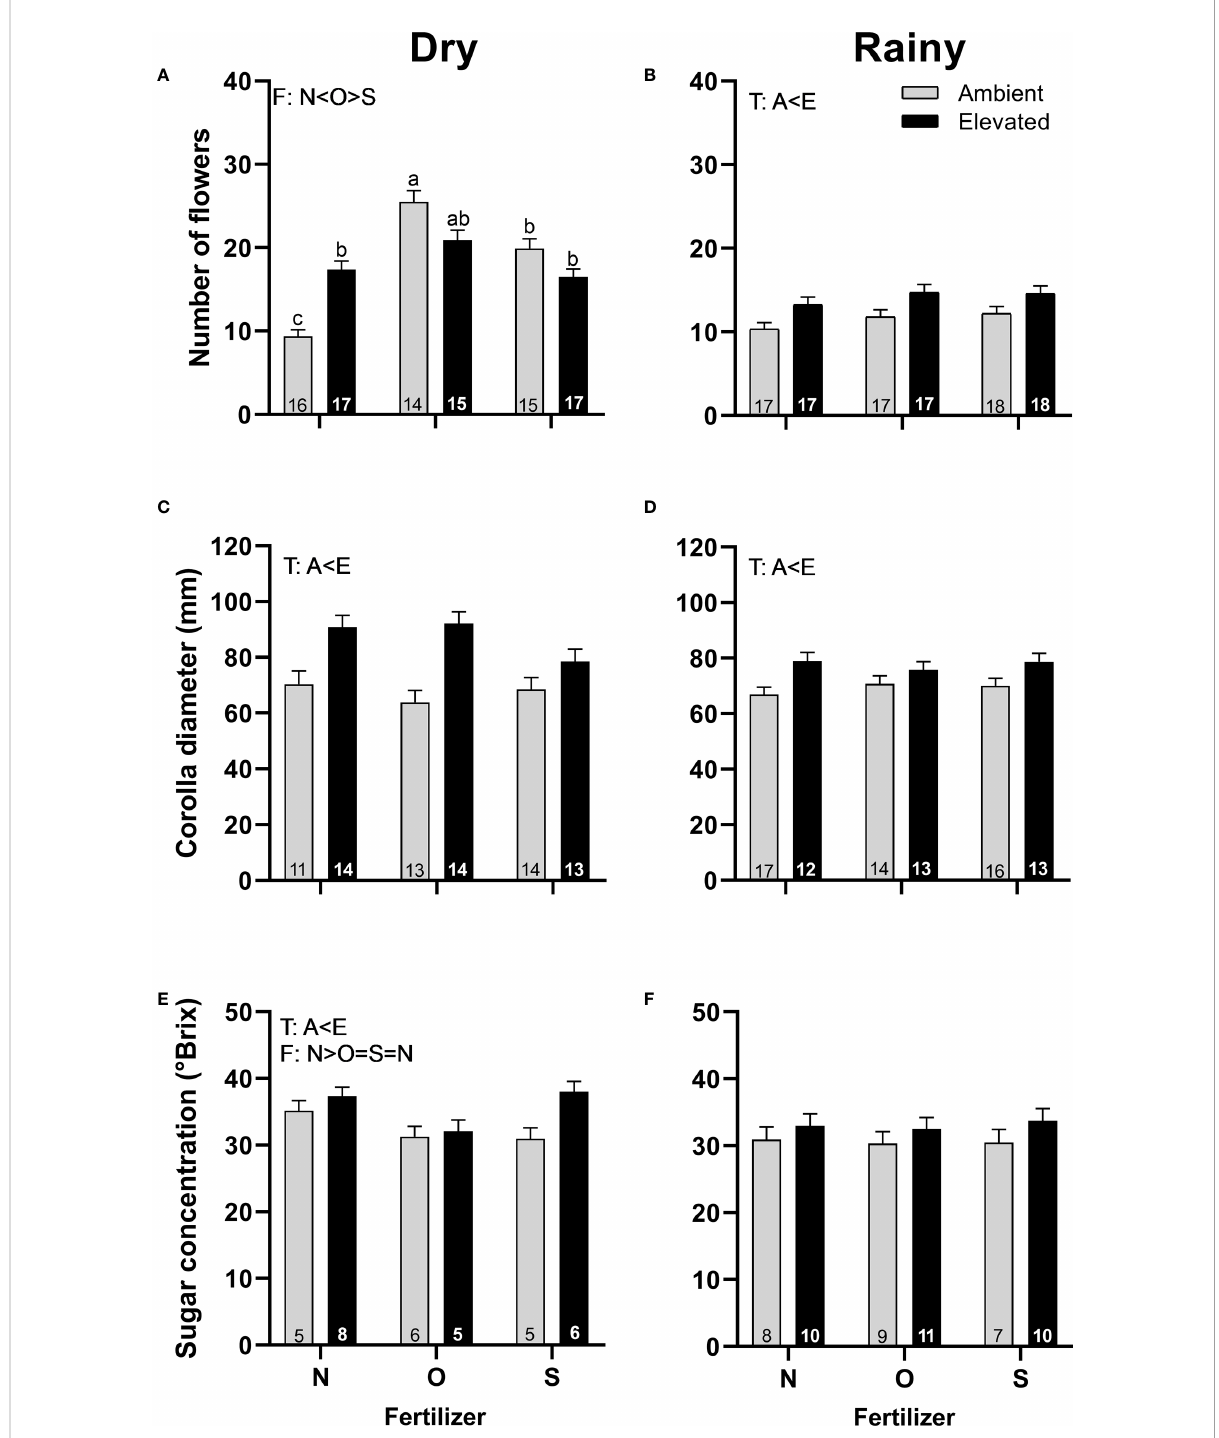
FIGURE 4 Effects of the increase in temperature (T) and addition of fertilizer (F) on the number of fl owers (A, B) , corolla diameter (C, D) , and sugar concentration (E, F) of staminate fl owers of C. pepo during the dry (left) and the rainy (right) season (mean ± SE; n: number inside bar). Signi fi cant differences in the main factors (T or F) are represented with capital letters (A, ambient temperature; E, elevated temperature; N, no supplementary fertilizer; O, organic fertilizer; S, synthetic fertilizer). Different lower-case letters above bars indicate statistically signi fi cant T x F interactions. Mean and standard deviation values are in Supplementary Tables 1, 2 and the results of the statistical tests are summarized in Supplementary Table